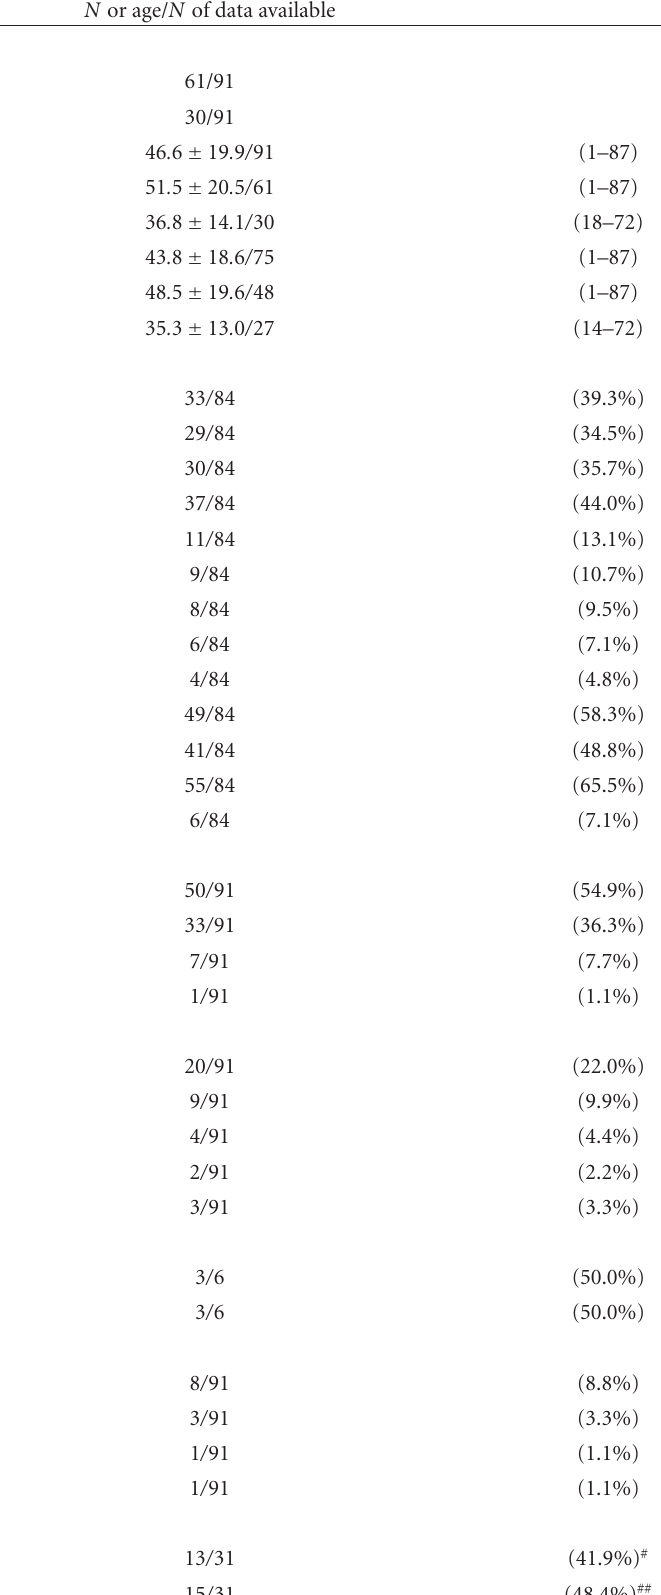
Table 1: Clinical characteristics of 91